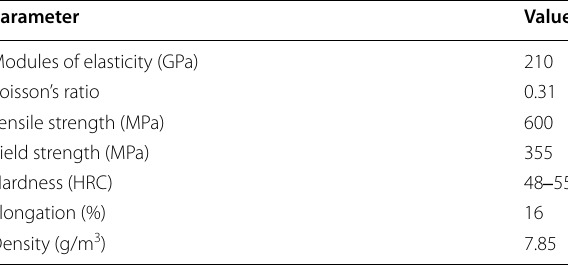
Table 5 Milling